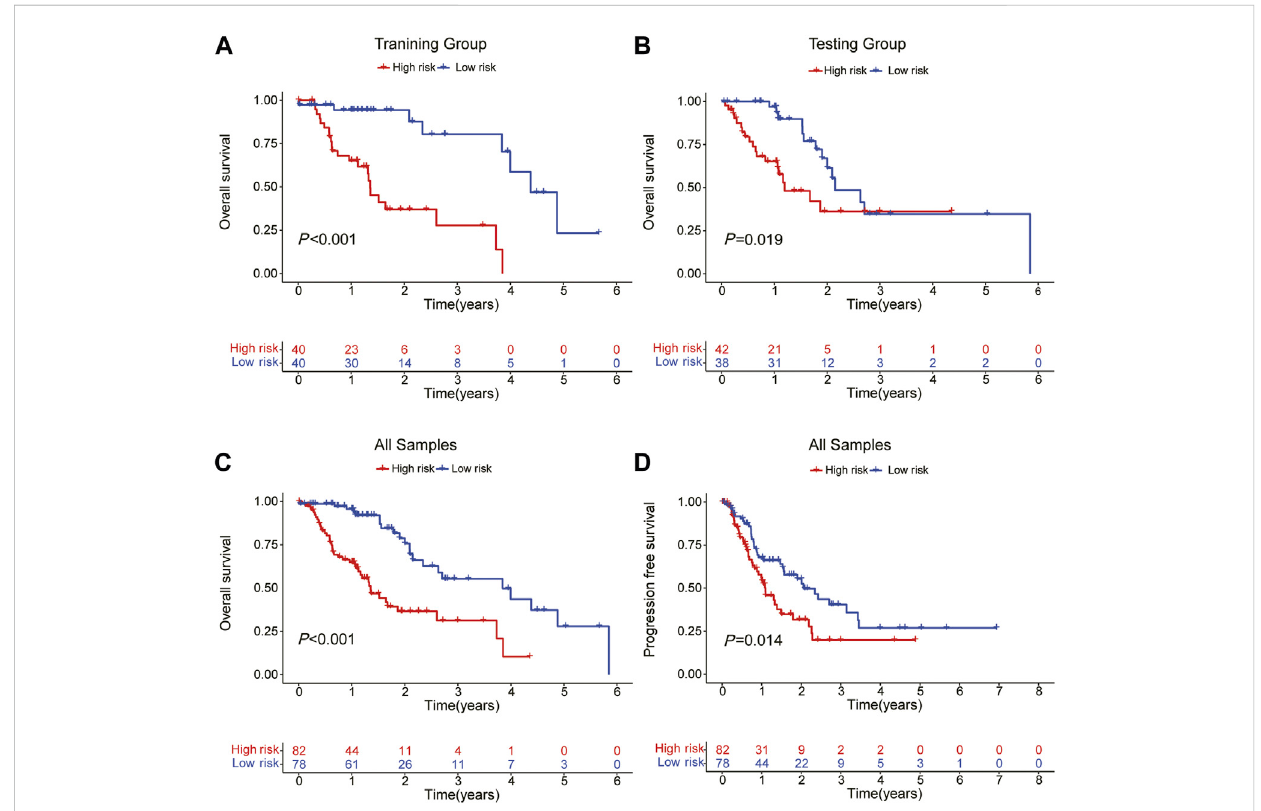
FIGURE 2 OSandPFSineachsubgrouppredictedbyKaplan-Meiersurvivalcurves. (A) OSinthetraininggroup. (B) OSinthetestinggroup. (C) OSinallsamples. (D) PFS in all samples.